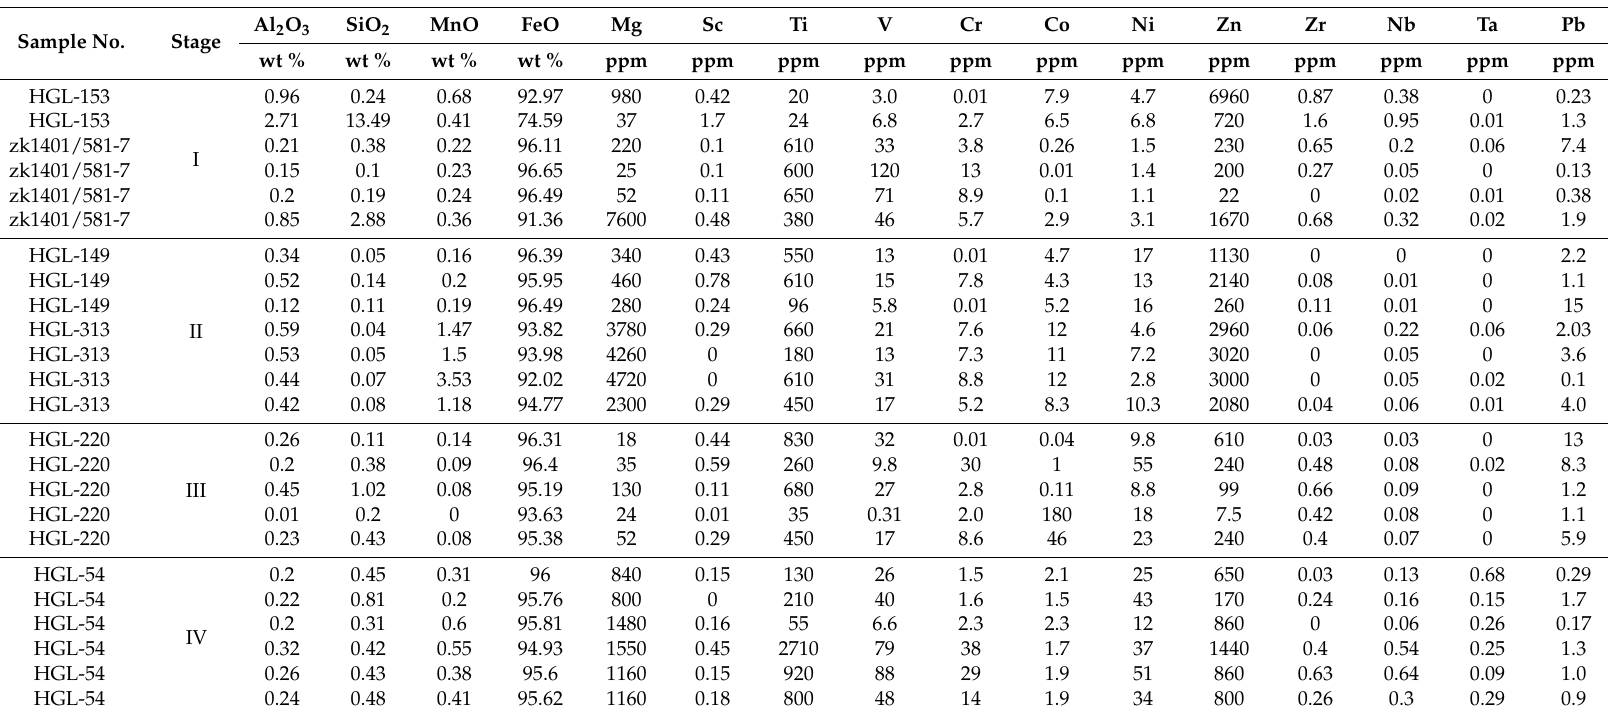
Table 2. Analytical results of selected ores from the Huanggangliang